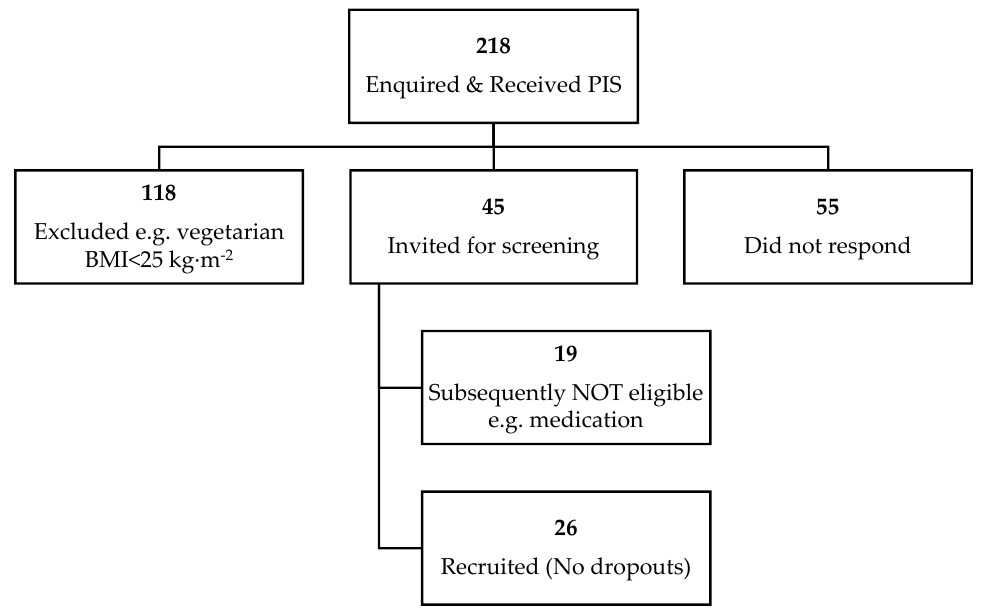
Figure 1. Flow diagram illustrating participant recruitment.